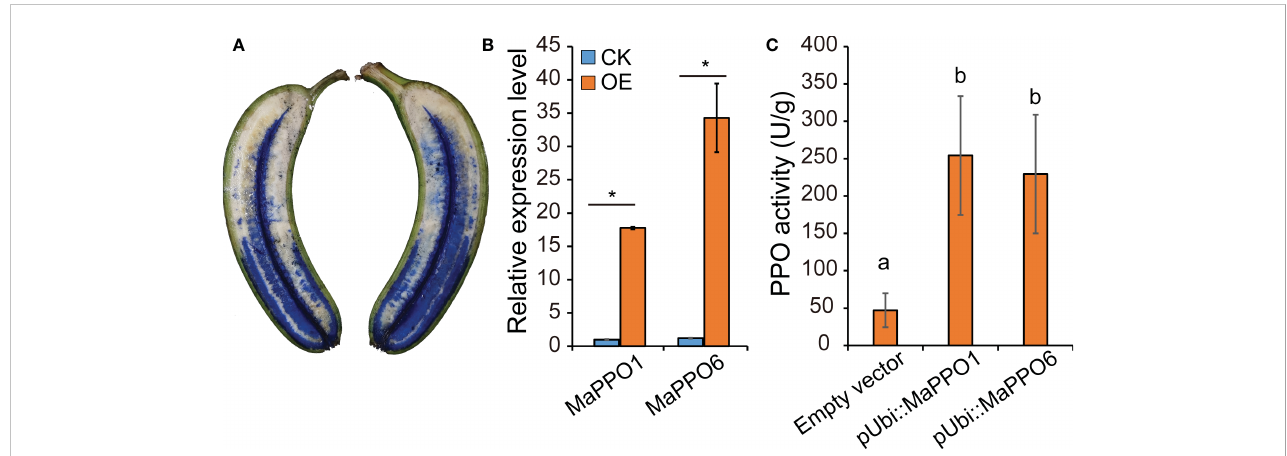
FIGURE 9 Transient expression analysis of MaPPO genes in banana fruit (A) Presentation of the delivery of Agrobacterium solution into banana pulp through the distal end of the fruit. (B) qRT-PCR analysis of the expression level of MaPPO genes. P-values were determined using Student ’ s t-tests. *P < 0.05. (C) Polyphenol oxidase activity of MaPPO -overexpressing fruit. Different letters indicate signi fi cant differences (P < 0.05) examined by one-way ANOVA.